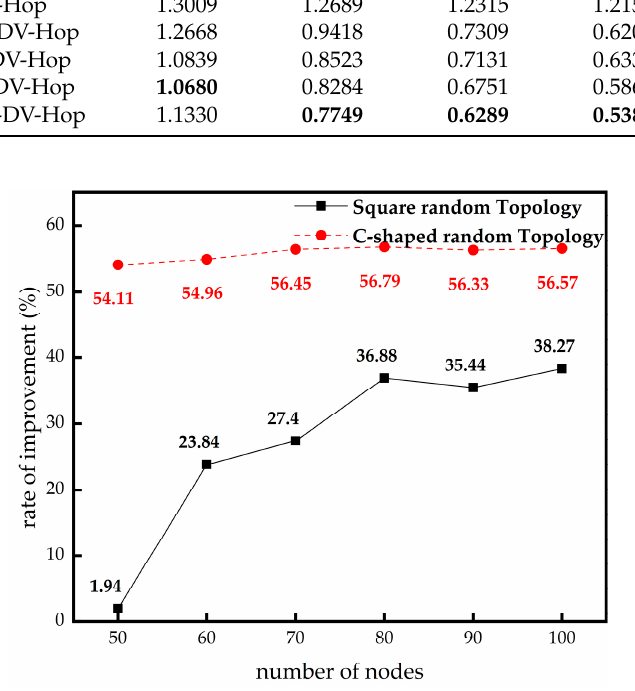
Figure 7. Comparison of localization error improvement in di ff erent number of nodes.